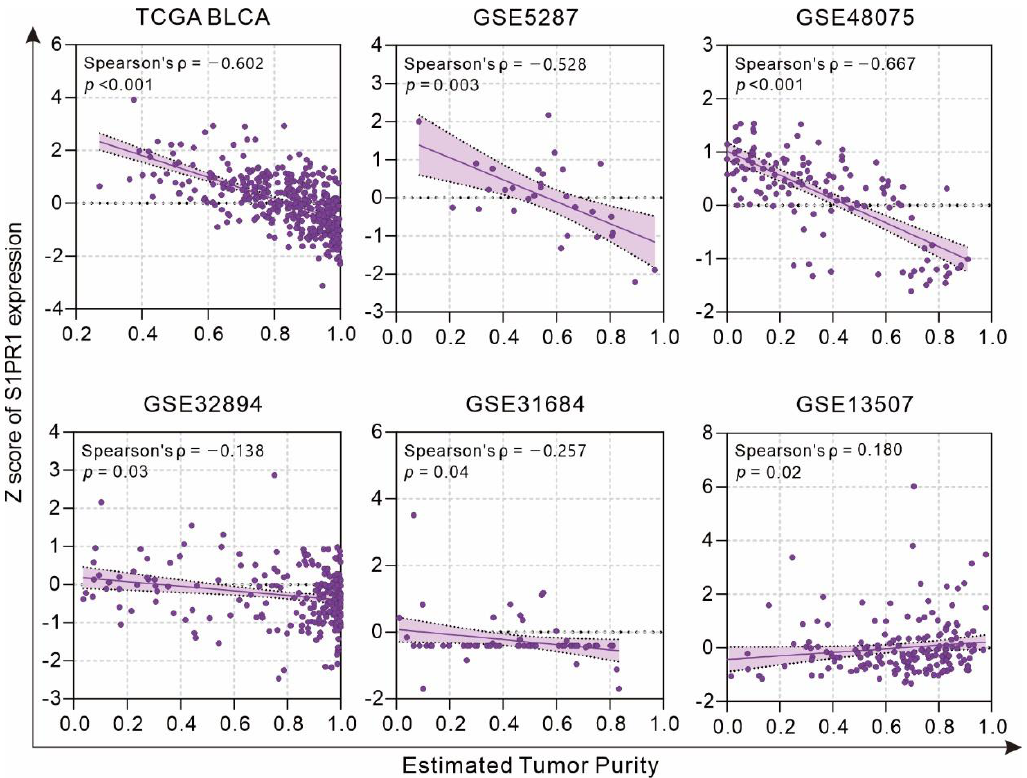
Figure 2. Association of S1PR1 expression with tumor purity. Further evaluation of the correlation between S1PR1 and immune cell populations